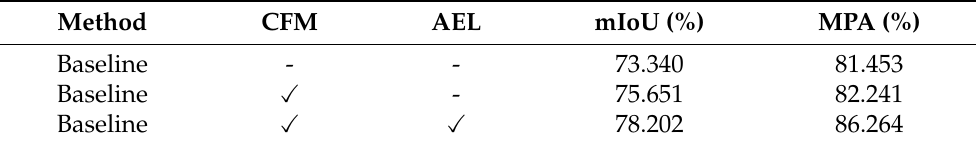
Table 2. Ablation study of Deeplab likewise models on Potsdam